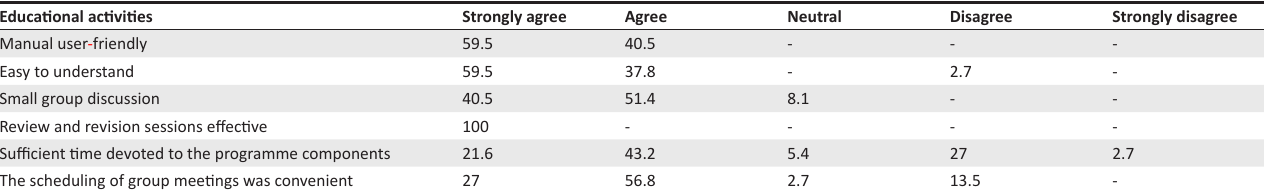
TABLE 1: Participant perception of the programme’s educational activities. Educational